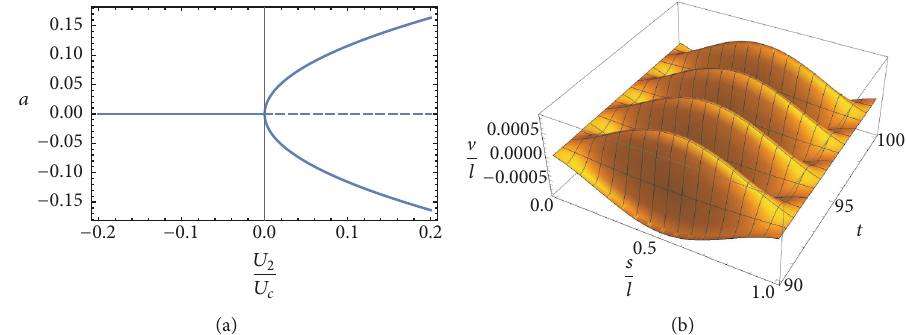
Figure 3: Case-study 1: (a) bifurcation diagram (solid line: stable; dashed line: unstable); (b) reconstituted displacement V (𝑠, 𝑡) of the cable for 𝑈 2 /𝑈 𝑐 = 0.11 .